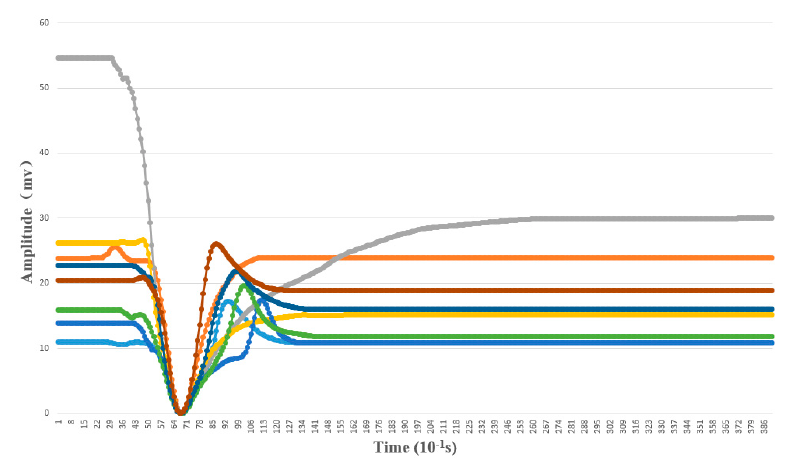
Figure 2. Flowchart of AP peak alignment.